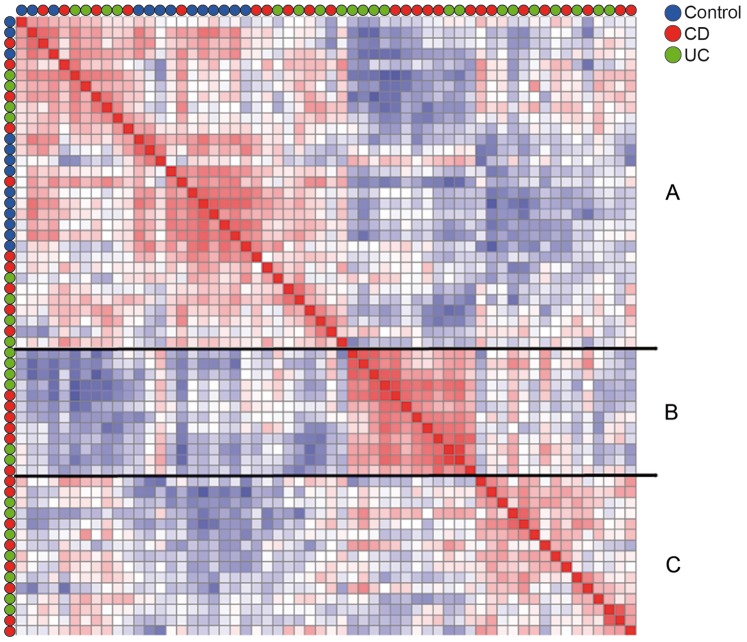
Correlation plot of quiescent IBD patients involving 2957 probe sets.Pair-wise correlations between the samples are depicted in a Pearson’s correlation plot. The colours of the cells relate to Pearson’s correlation coefficient values, with deeper colours indicating higher positive (red) or negative (blue) correlations. This Pearson’s correlation plot revealed three distinct groups (A, B, C). Controls are annotated to group A.